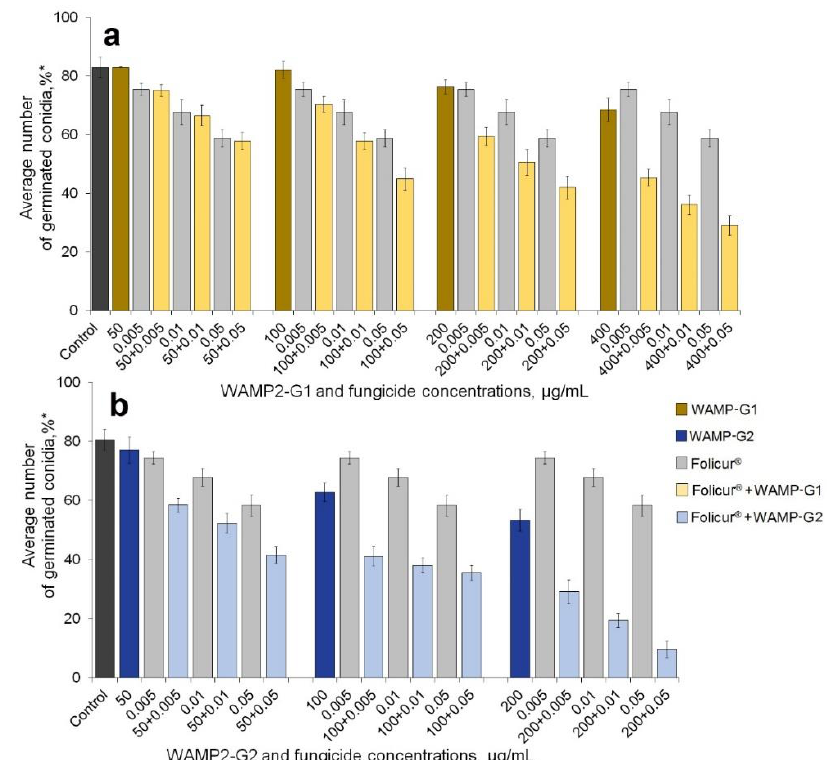
Figure 2. Inhibitory effect of Folicur ® EC 250 on germination of Fusarium oxysporum microconidia exposed to ( a ) WAMP-G1 or ( b ) WAMP-G2 derived from the central regions of a wheat hevein-like antimicrobial peptide WAMP-2, ( a , b ) to Folicur ® , alone, and to this fungicide in combination with ( a ) WAMP-G1 or ( b ) WAMP-G2. * The average number of germinated conidia relative to the total number of counted conidia is expressed in percent. Microconidia germinated in SDW were served as controls. The means are calculated for 1000 conidia per treatment ( n = 500 per treatment in each of three experiments) Y-bars indicate SD at p ≤ 0.05. For additional explanations, see Figure 1.